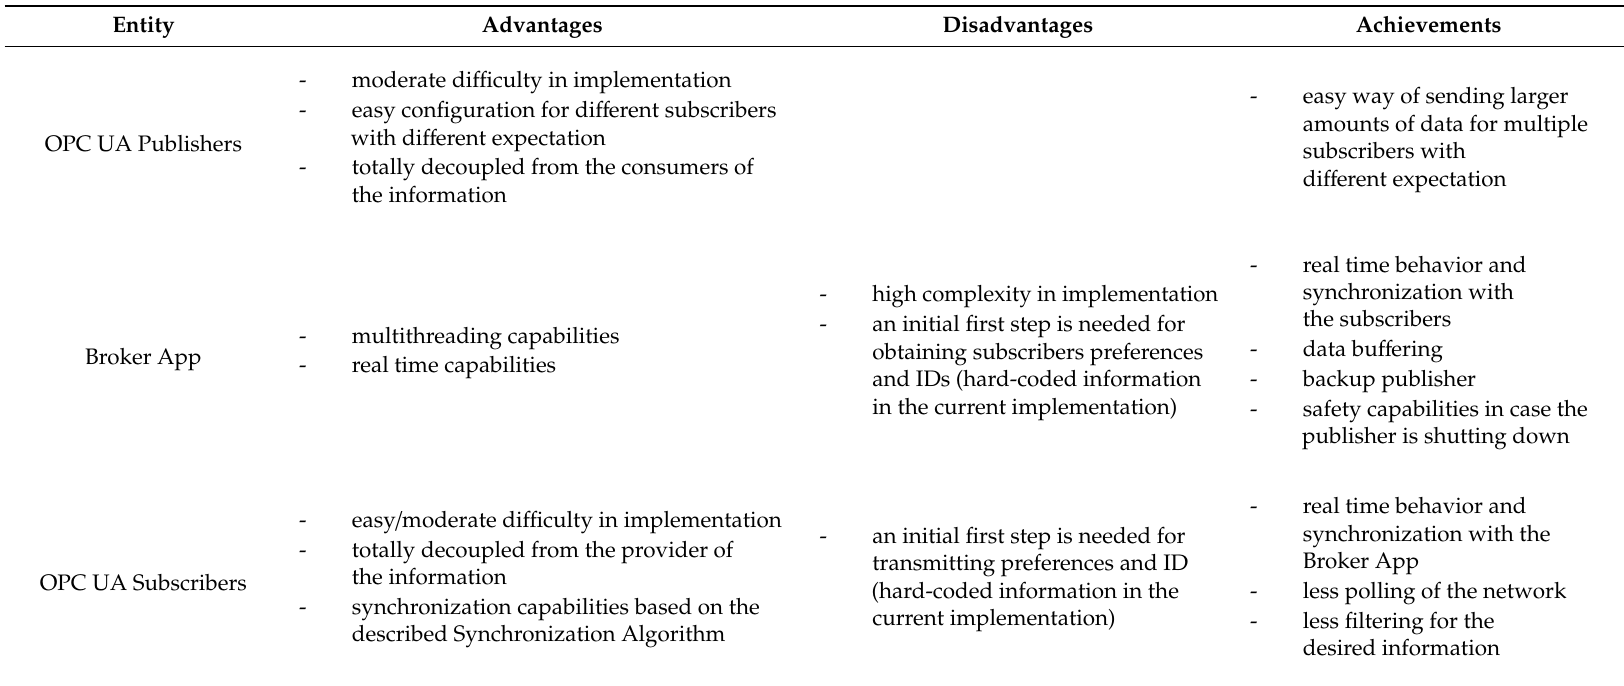
Table 1. Case study results